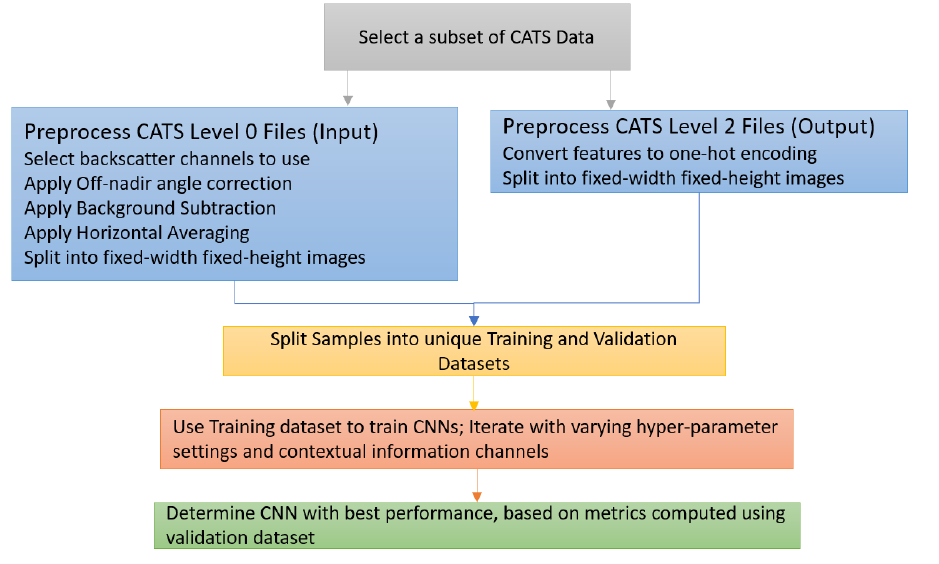
Figure 6. The flow of the CATS CNN model development starts with the subset of the CATS data chosen as the test data and ends with a selection of the CNN model with the best prediction metrics, as shown in this